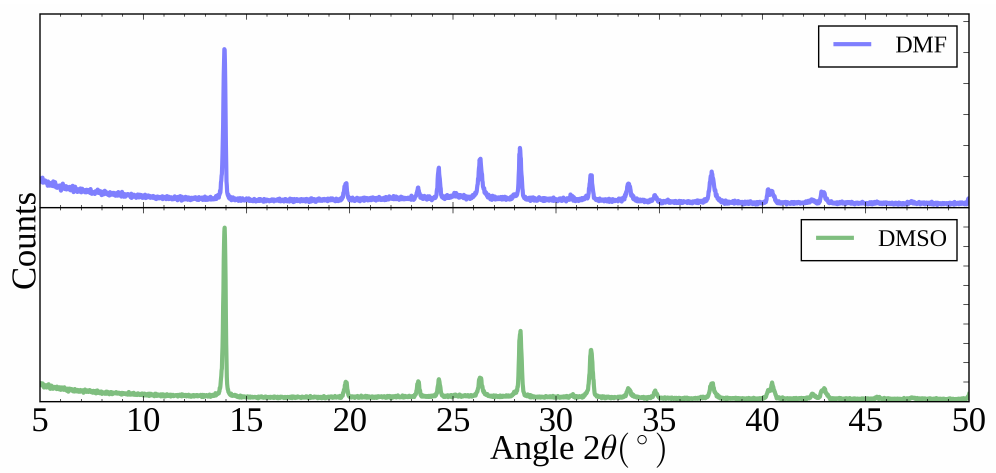
Figure 5. XRD spectra of perovskite films formed from dip coating of lead iodide films from either DMF or DMSO-based inks.